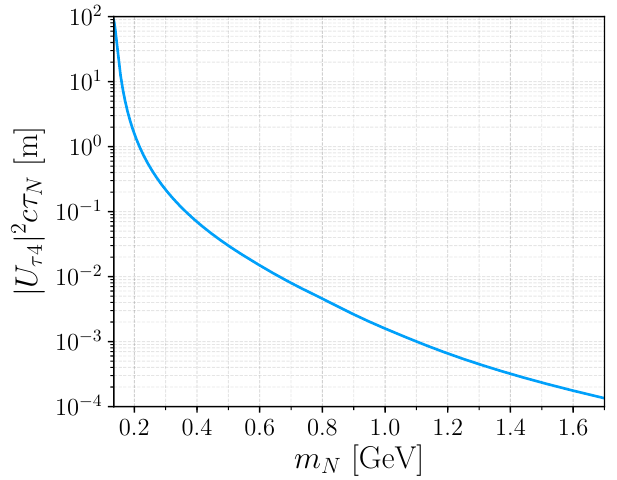
Figure 3 . Proper decay length of the sterile neutrino times | U τ 4 | 2 in the minimal